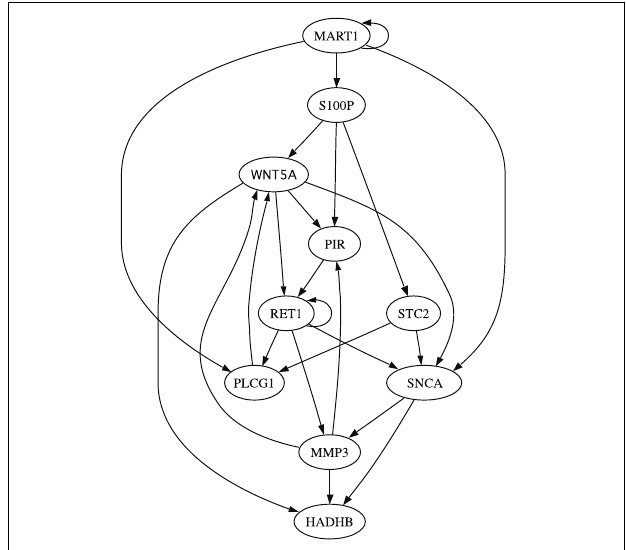
FIGURE 6 | Multivariate relationships among genes in the metastatic melanoma network.